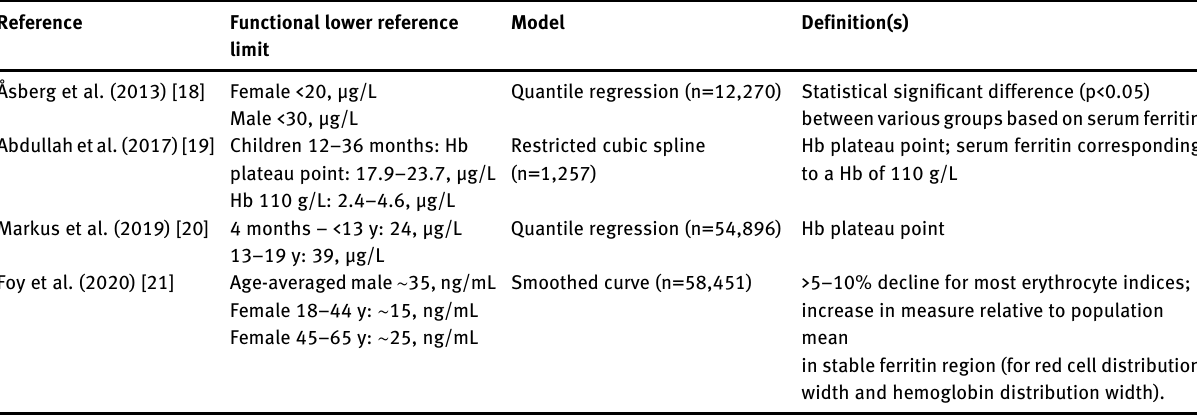
Table  : Various models and de fi nitions used to calculate functional reference limits for serum ferritin.